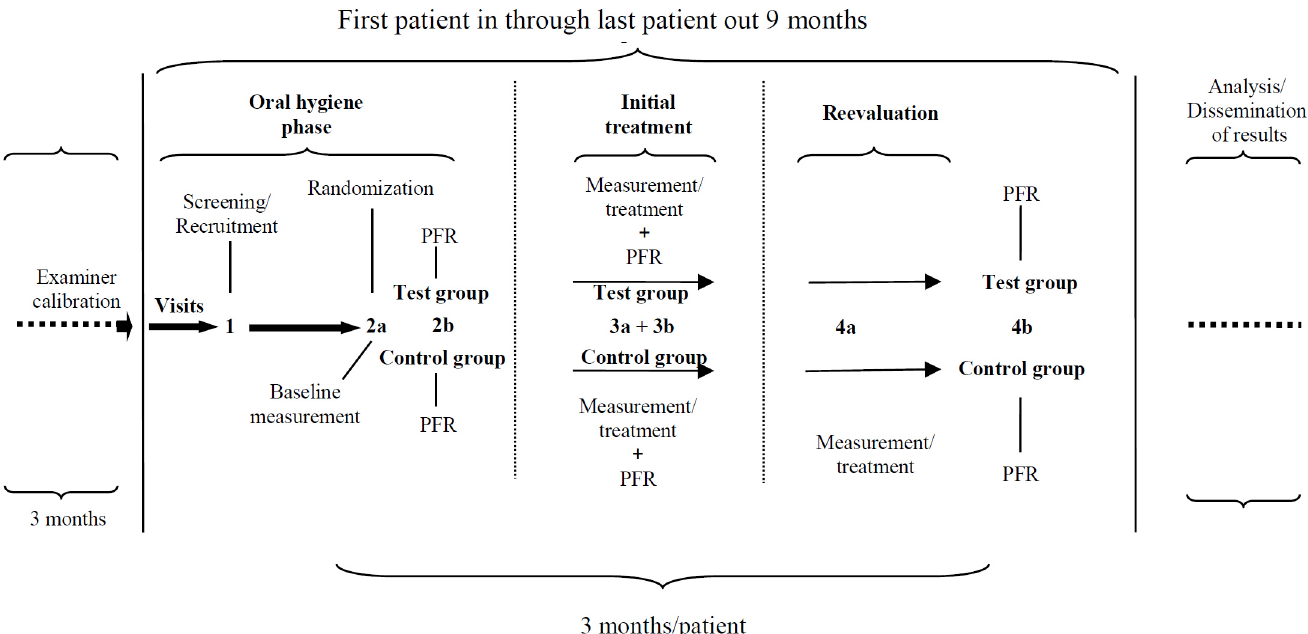
Fig 1. Study design. Visits 2b, 3b, and 4b were scheduled 24 hours following visit 2a, 3a, and 4a, respectively. PFR: Plaque formation rate; Test: microcrystalline zinc hydroxyapatite (mHA) dentifrice; Control: fluoridated control (AmF/SnF 2 ) dentifrice.